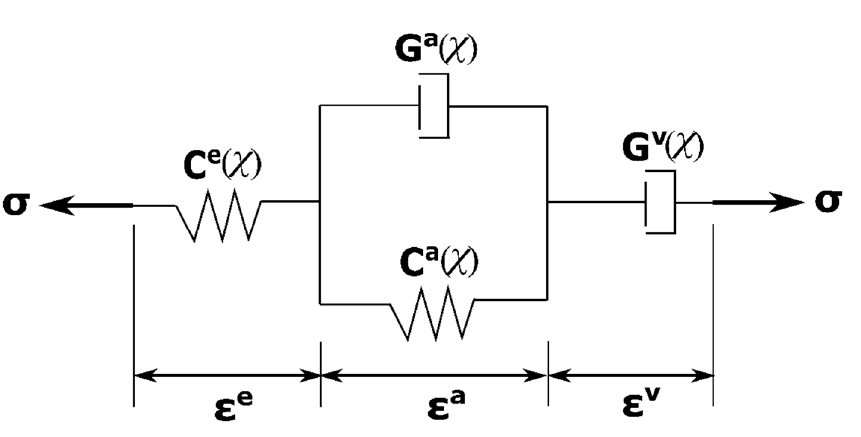
Figure 7. Burger’s rheological model of the anode.